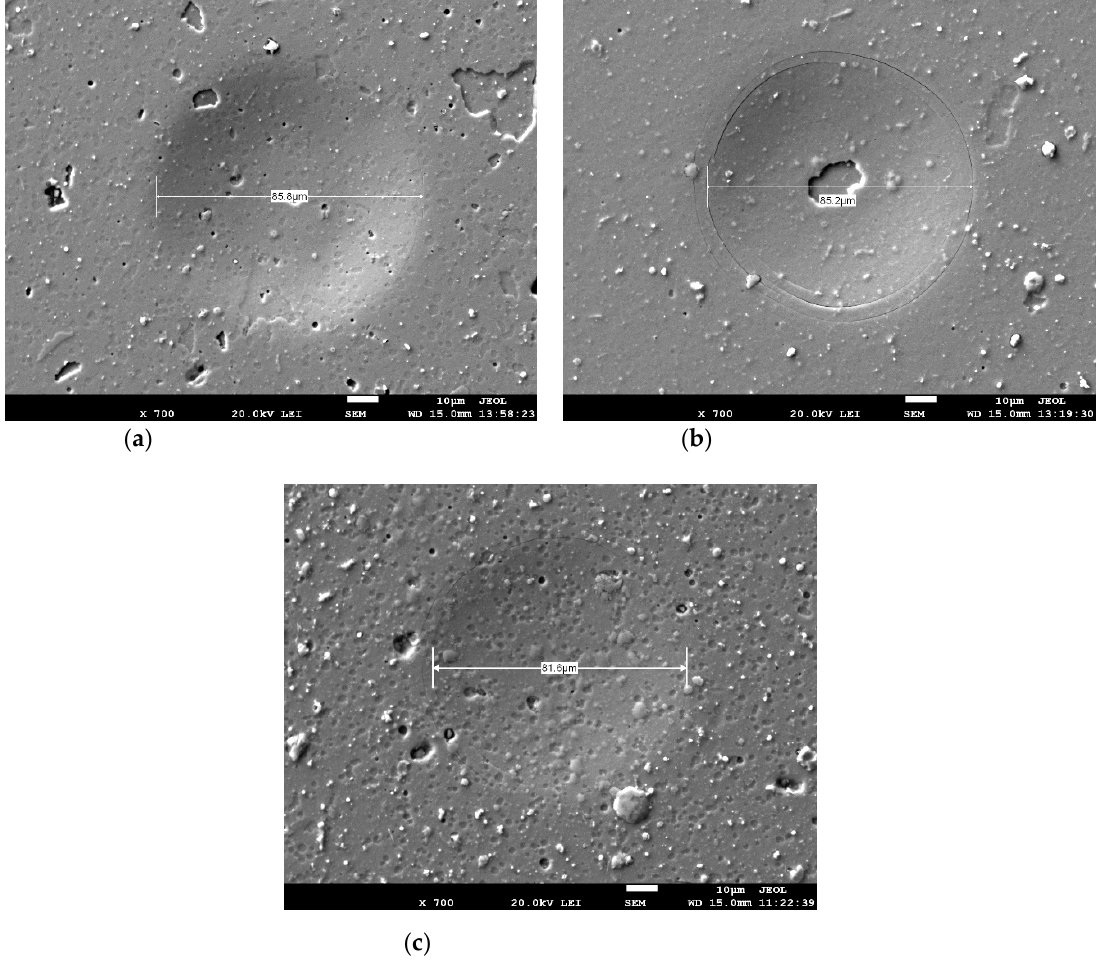
Figure 9. Hits Energy curves TiXCo3/HSS, nACo3/HSS, and nACo3/SC captured at the maximal force of ( a ) 50 N and ( b ) 1500